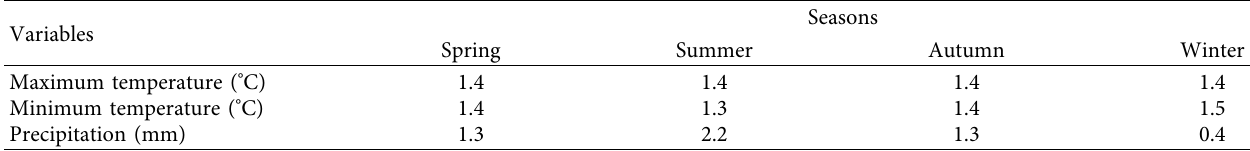
Table 6: Mean absolute error of variables during the validation period.